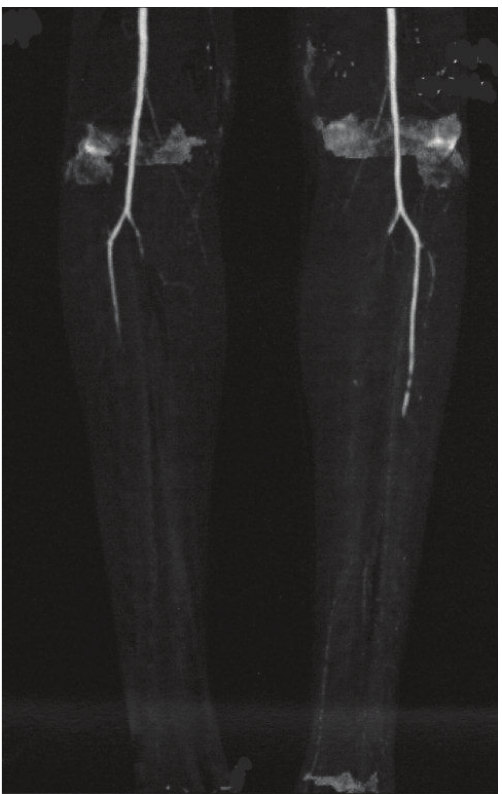
Figure 1: CT angiography showing the presence of an intraluminal aortic (short arrow) and iliac (long arrow) saddle embolus.